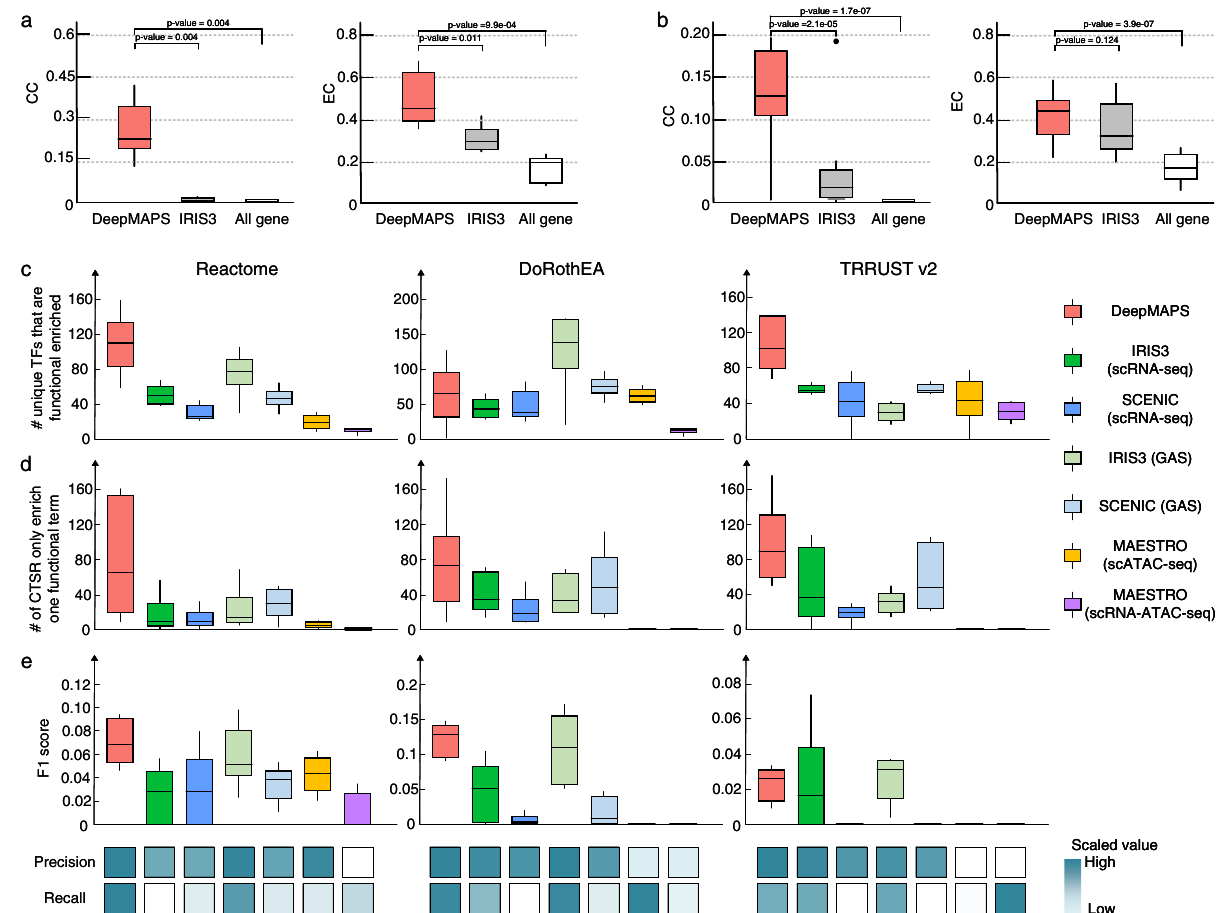
Fig. 3 | Evaluation and comparison of gene association network inference of DeepMAPS. a , b Closeness centrality (CC) and eigenvector centrality (EC) were used to indicate the compactness and importance of genes to the network. We compared our results with IRIS3 and a background network using all genes for the R-testdataset( n =5) a andC-testdataset( n =14) b . p -valueswerecalculatedusinga two-tail t-test. c Comparison of the number of unique TFs in GRNs that showed signi fi cantly enriched biological functions in three public databases. Each box contains the results of six scRNA-ATAC-seq datasets ( n =6). d Comparison of the number of cell-type-speci fi c regulons in GRNs signi fi cantly enriched in only one